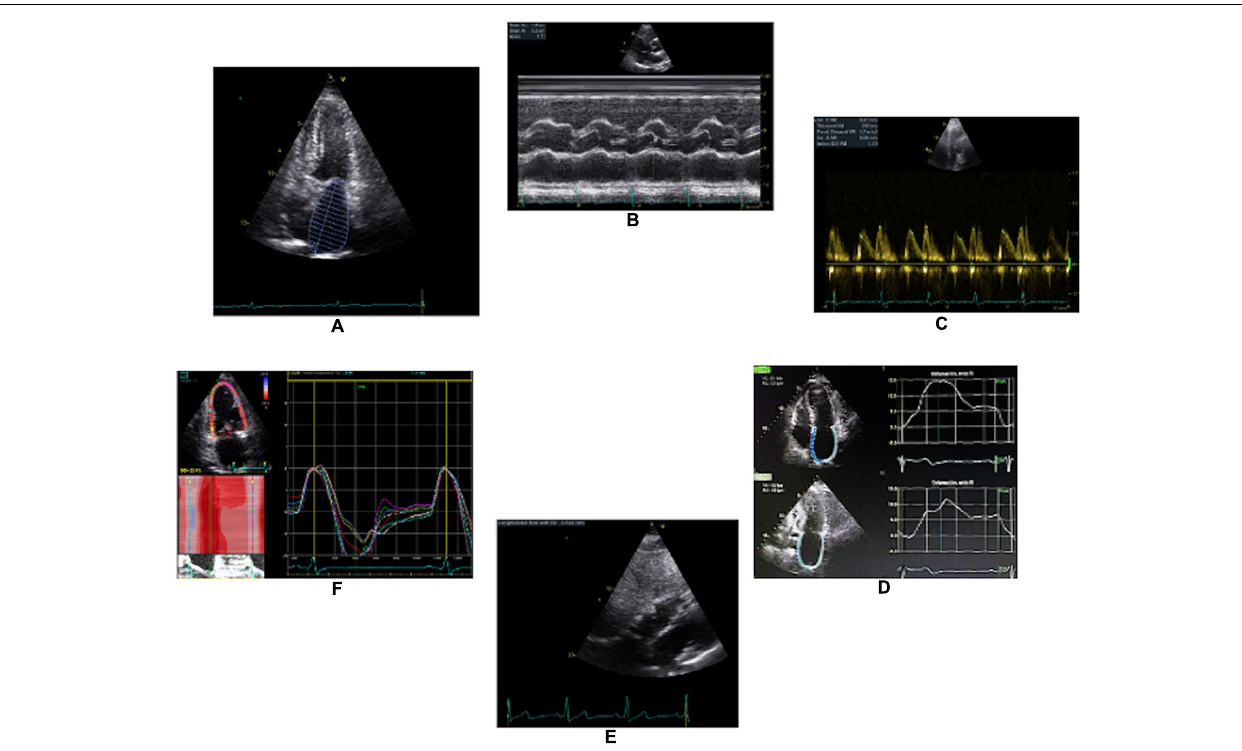
FIGURE 2 | Illustration of some TTE parameters that will be recorded throughout a standardized protocol. (A) , left atrial size; (B) , left ventricle thickness; (C) , E and A waves; (D) , left atrium strain; (E) , right ventricular thickness; and (F) , left ventricular longitudinal